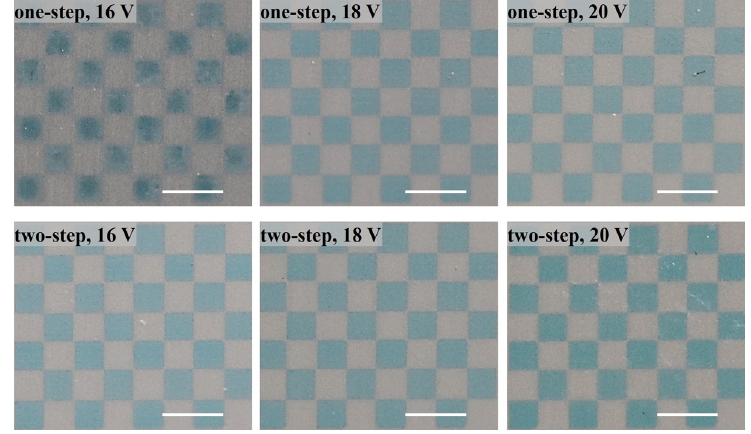
Figure 11. Images of inkjet-printed 0.5 mm × 0.5 mm square arrays on the AAO films produced by one-step and two-step anodizing with applied voltages of 16, 18, and 20 V (scale bar 1 mm).